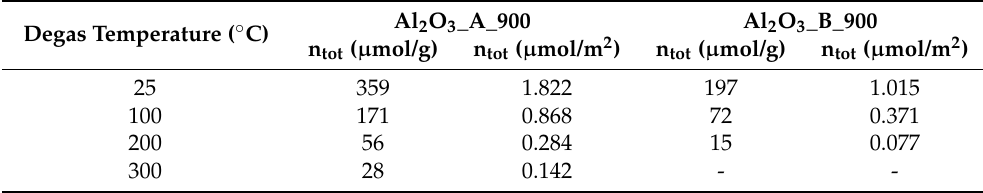
Table 3. Amount of acid sites determined by FT-IR of adsorbed pyridine for Al 2 O 3 _A_900 and Al 2 O 3 _B_900, after degassing at 25, 100, 200, and 300 ◦